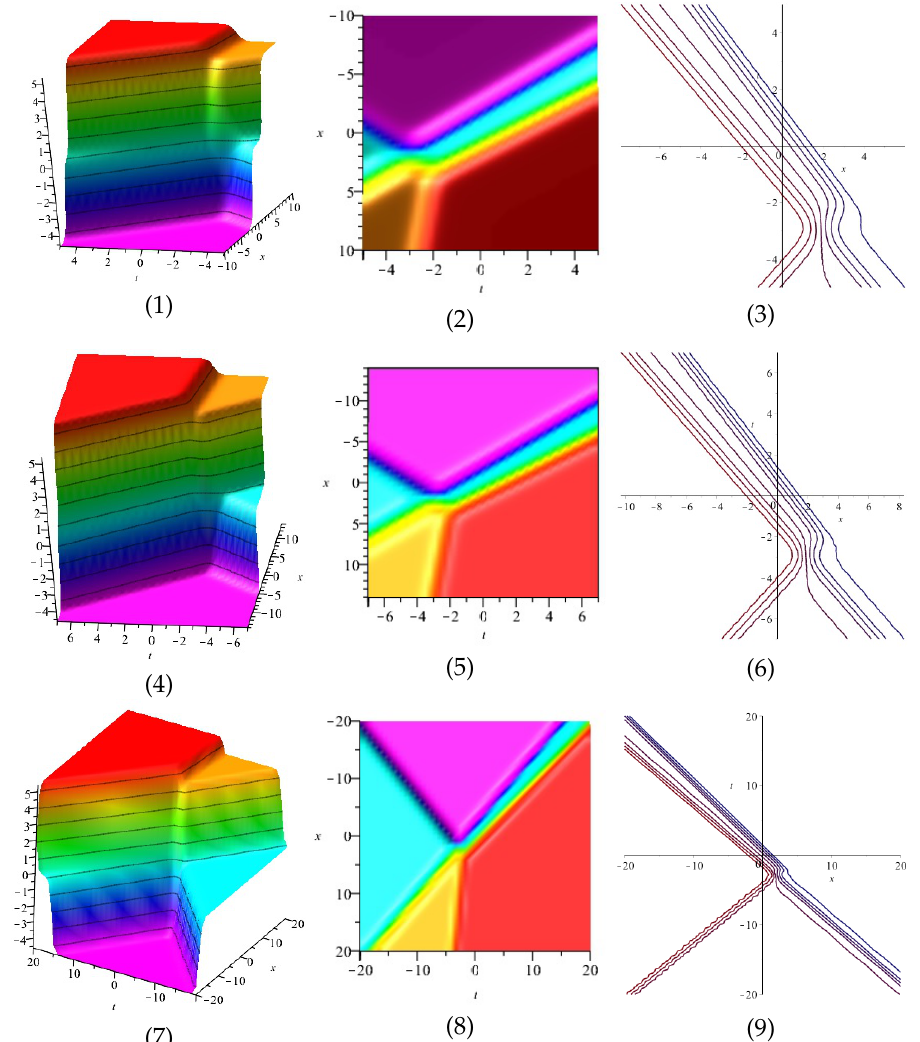
Figure 7. The 3D and 2D with the diagram of u 3,3 , in three different domains, for R 3 = − 2.70, A 1 = − 2.70, A 2 = 2.80, S 1 = 2.20, S 2 = 2.70, and S 3 = − 2.30. ( 2 ) , ( 5 ) and ( 8 ) display the z − axis orientation and ( 3 ) , ( 6 ) and ( 9 ) are contour plots.